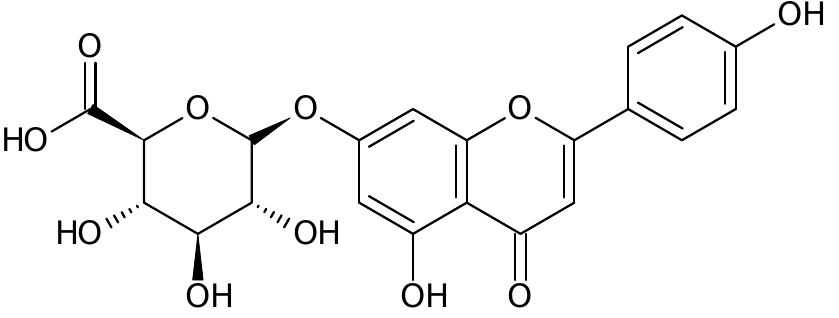
Figure 1. Structure of apigenin-7-O-glucuronide.